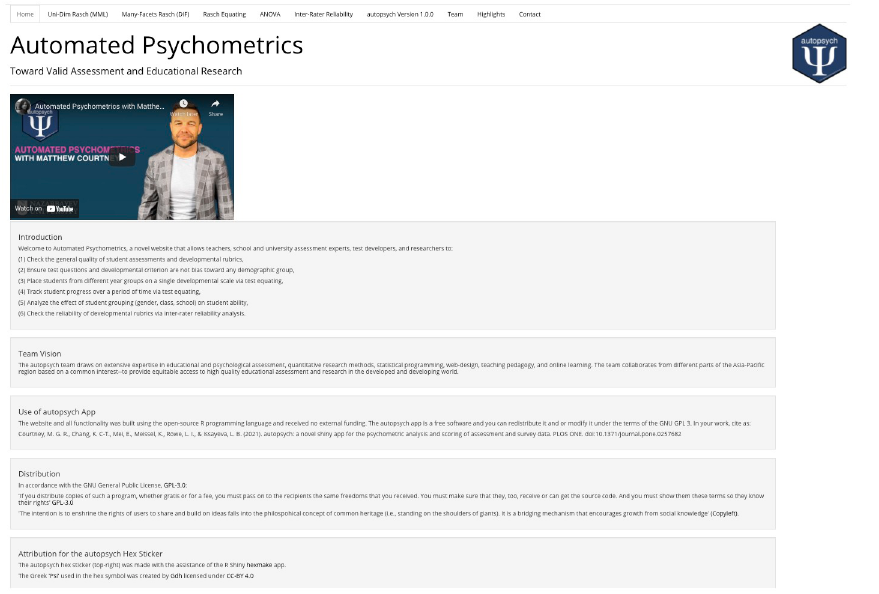
Fig 1. Homepage of